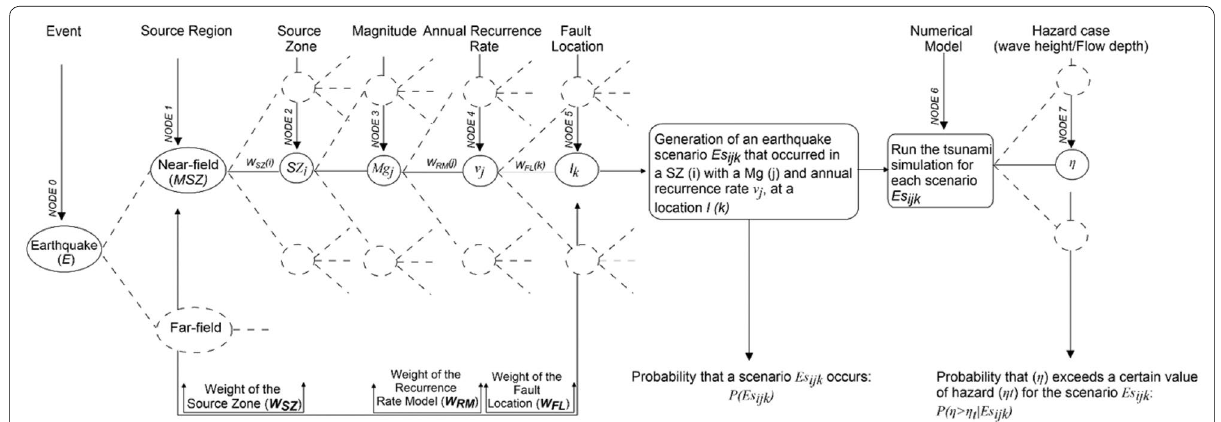
Fig. 2 Logic tree developed for probabilistic tsunami hazard assessment along the coast of